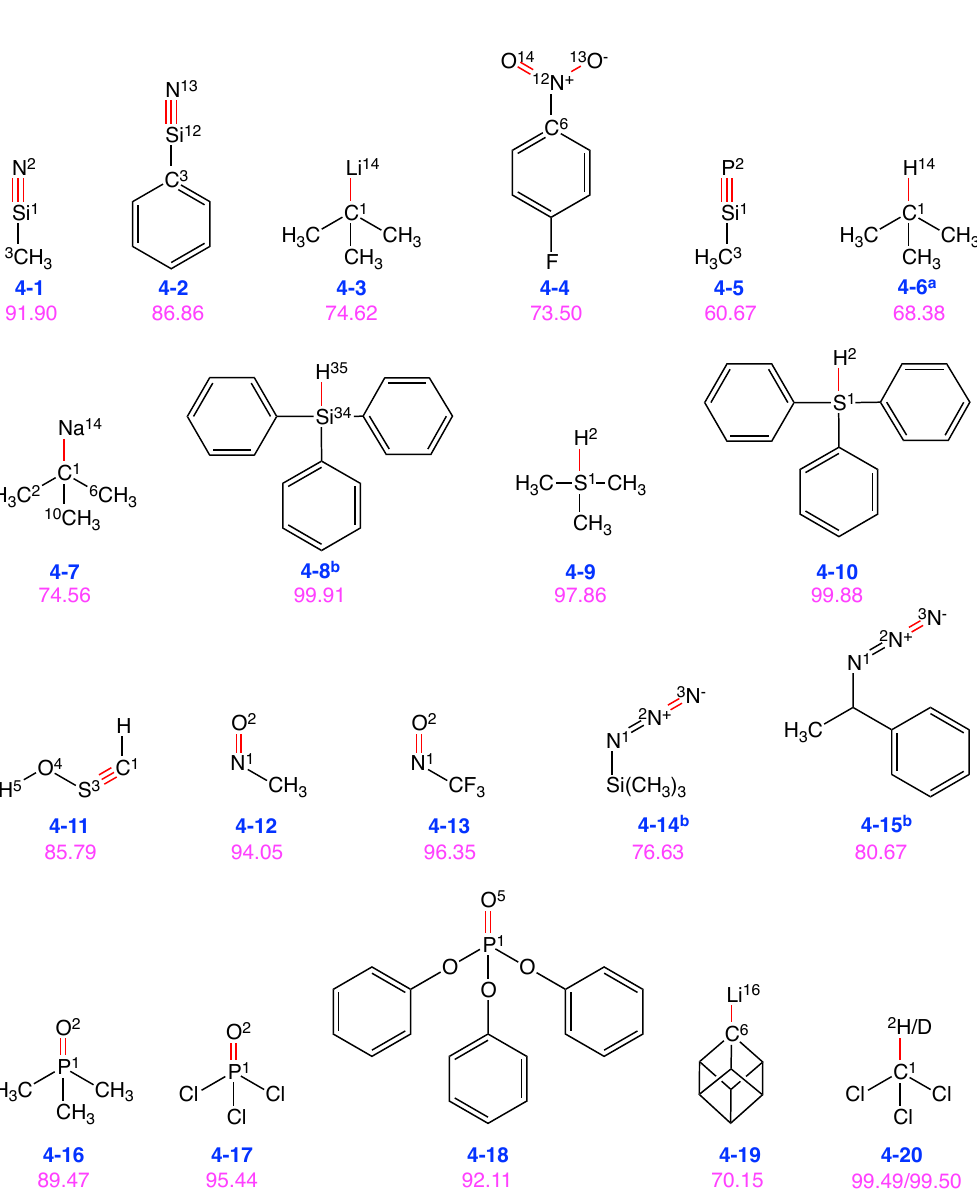
Figure 7. Group 4: 20 VSE probes with miscellaneous probe bonds in red. Below each structure, the label n-m is given in blue, n denotes the group number (reflecting the type of VSE probe bond), and m is the number of this molecule in this group. Vibrational probe labels with superscripts are taken from the literature (a [18]). The corresponding performance score as VSE probe is given in purple. The number in superscript refers to the atom index in the molecule. The superscripts are shown only for the atoms whose associated local modes participate in the normal mode of probe bond stretching with more than 5%